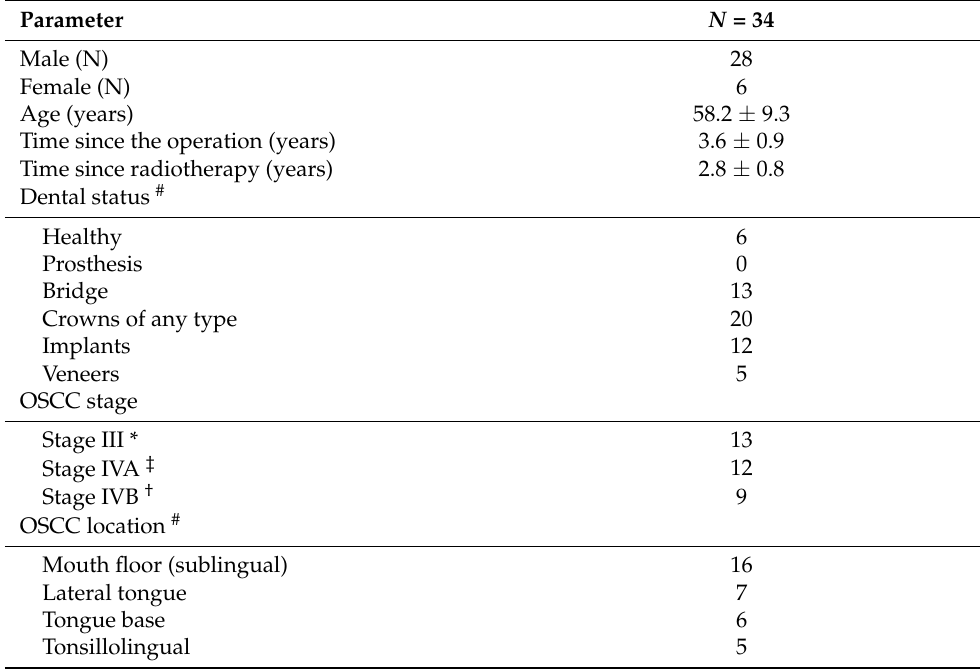
Table 1. Baseline characteristics of the study